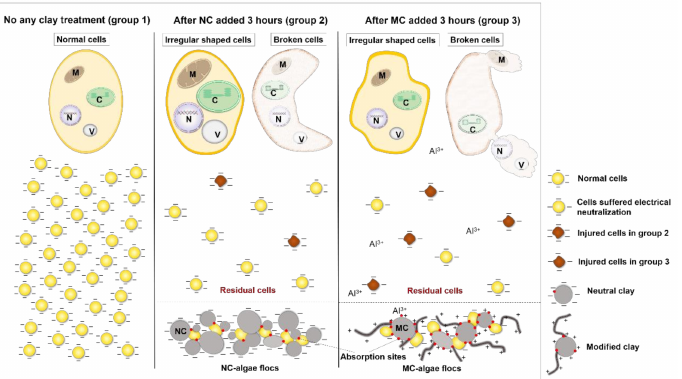
Figure 8. Schematic showing the proposed cell morphology changes for HAB controlled by NC and MC. In group 2, there were some irregularly shaped and cytoplasmic granularity increase residual cells, and broken cells suffered a large area of membrane depression. In group 3, the proportion of irregularly shaped and broken cells is larger than that in group 2, and broken cells with cytoplasmic contents released from the membrane pores. C, chloroplast; M, mitochondrion; N, nucleus; V,